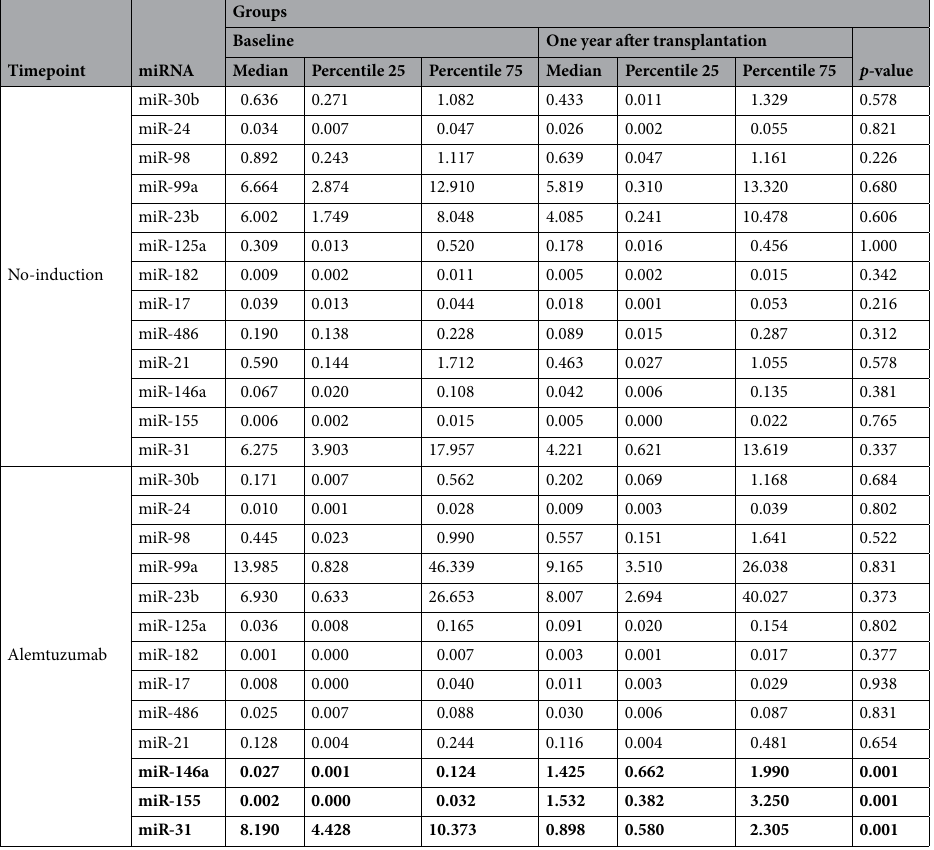
Table 2. MicroRNA expression differences within the groups between the baseline and one year after transplantation. Significant values are in [bold/italics].